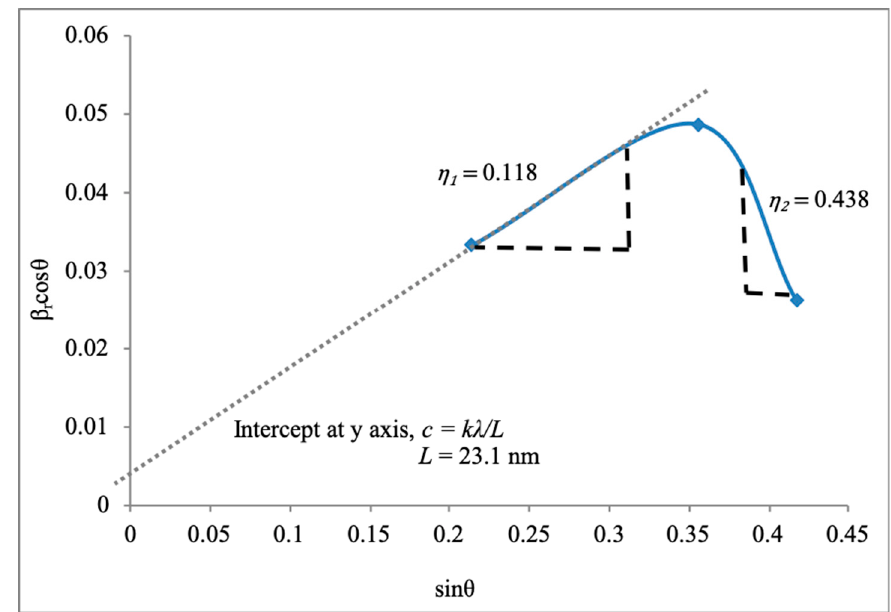
Figure 7. Plot of β r cos θ versus sin θ from XRD data of the 1 min sample.